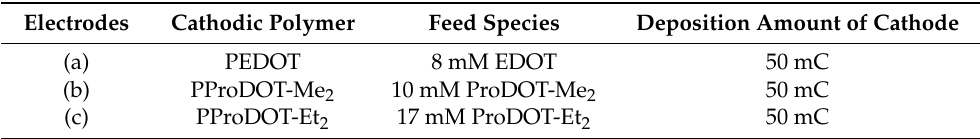
Table 1. Feed species of cathodic polymer electrodes